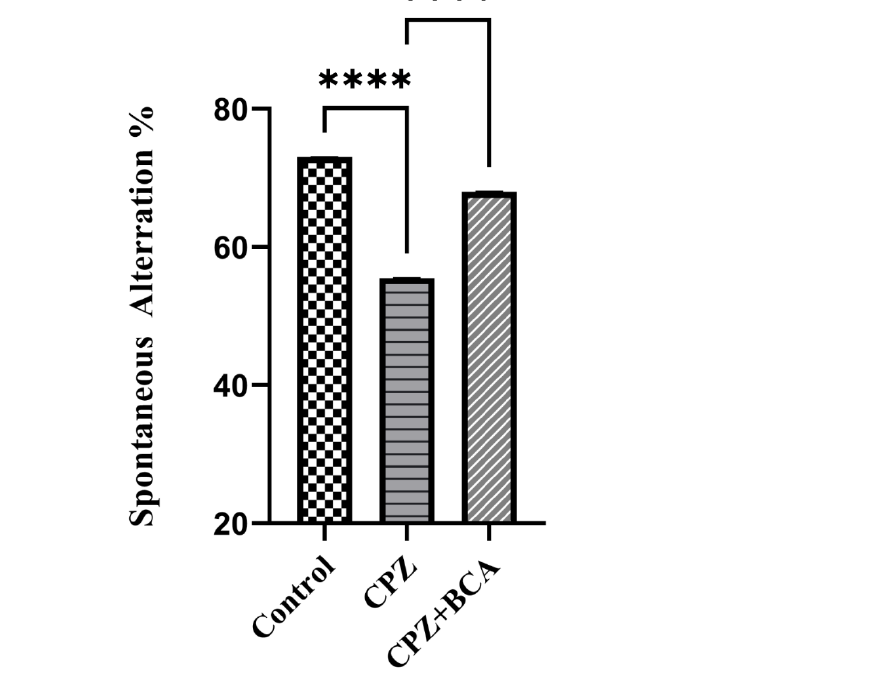
Figure 3. Y-maze spontaneous alteration task. CPZ significantly decreased the alteration % com- pared with the control group while BCA significantly increased the alteration % in CPZ + BCA group compared with the CPZ group. One-way ANOVA, followed by Tukey’s test was used. Data are present as mean ± SEM. **** p < 0.0001. (CPZ: cuprizone, BCA: biochanin